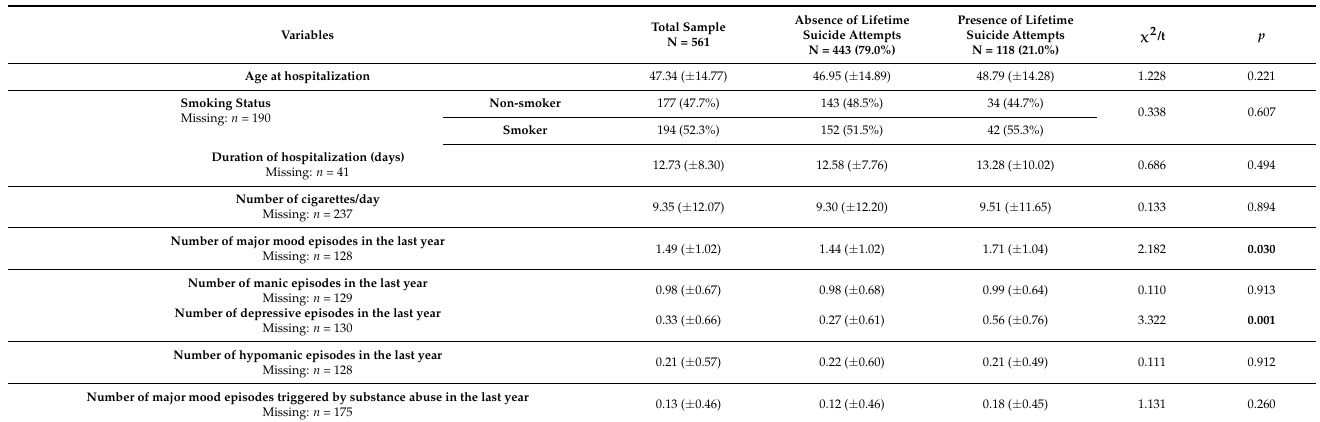
Table 2. Recent (last year) or current clinical variables of the total sample and of the two groups obtained according to the presence of lifetime suicide